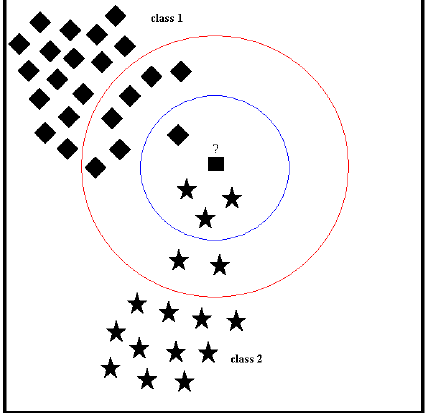
Figure 8. An example of the selection of the parameter k in the k -NN algorithm. The inner circle corresponds to k = 4 and the outer circle corresponds to k = 12 , producing different classification results for the test